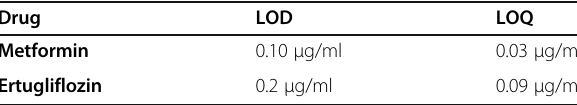
Table 4 LOD and LOQ results of Metformin and